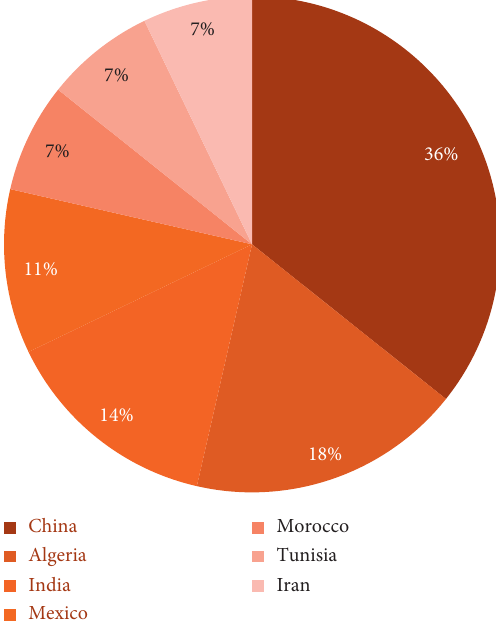
Figure 6: Research distribution by countries with more than one publication.